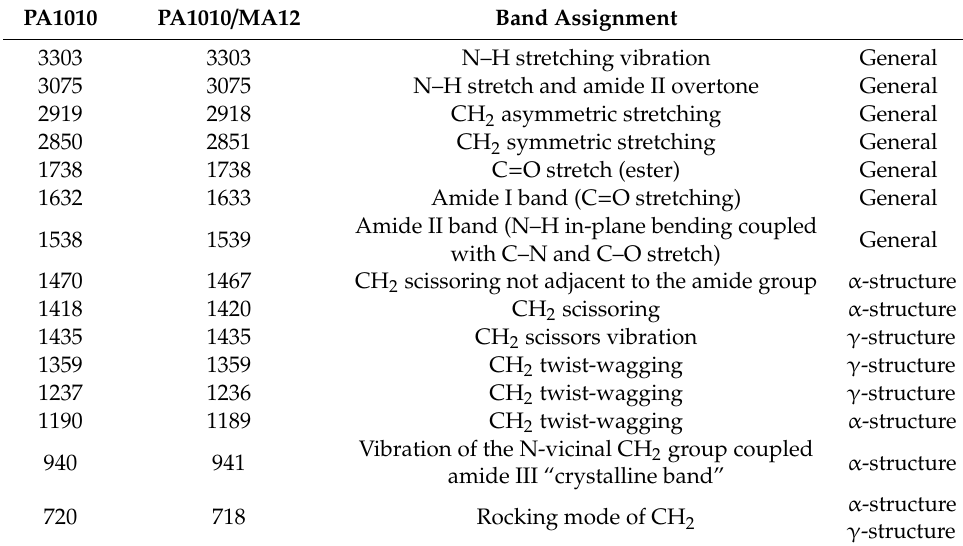
Table 3. Assignments of the FTIR bands for PA1010 and PA1010 / MA12